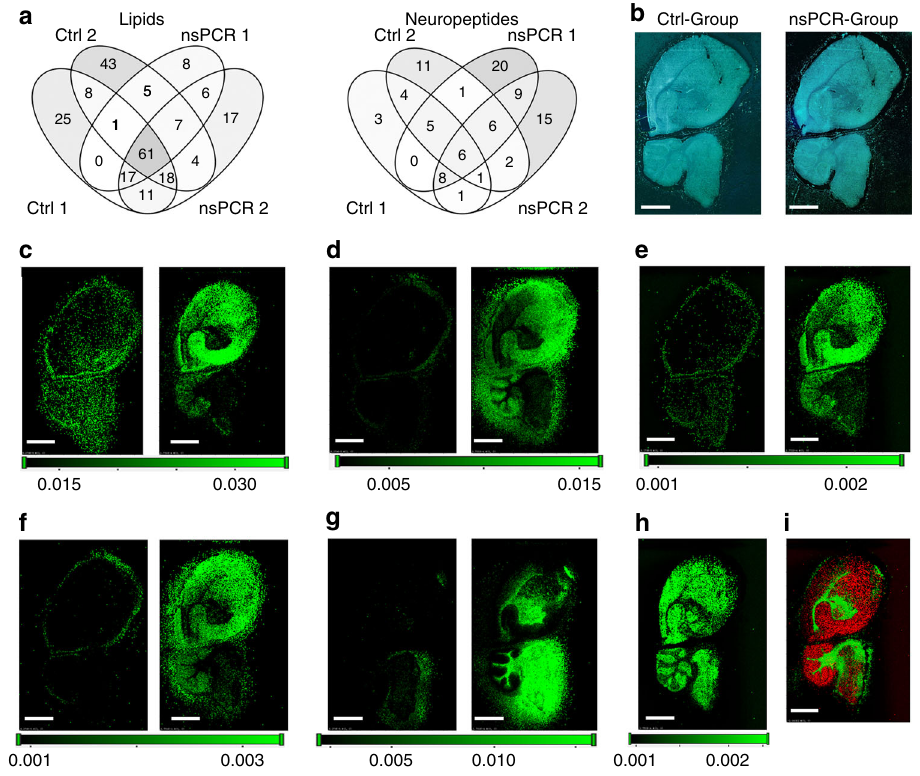
Fig. 2 Enhanced neuropeptide visualization via nsPCR. a Venn diagrams showing two sets of comparative data for both lipid and neuropeptide identi fi cations with and without NBA treatments. b Optical images of mouse brain for control and experimental group with NBA. c Direct comparison of putative neuropeptide ADKNFLRFamide ([M + H] + , m/z 1009.568) without (left panel) and with NBA treatment (right panel); d APQRNFLRFamide ([M + H] + , m/z 1147.650); e RKPPFNGSIFamide ([M + K] + , m/z 1199.610); f RSAEGLGRMGRL ([M + K] + , m/z 1340.660). g Direct comparison of lipid (triacylglycerol, [TAG(52:9) + Na] + , m/z 867.651) distributions in mouse brain between control and labeled group with NBA. h Typical distribution of lipid (monomethyl-phosphatidylethanolamine, [MMPE(44:10) + 34 + Li] + , m/z 878.645) with NBA. i Overlay of lipid (phosphatidylcholine, [PC(36:1) + H] + , m/z 788.615, red) and neuropeptide ([SKNYLRFamide + H] + , m/z 926.522, green) ion images. All images were obtained with m/z tolerance of 5 ppm. Scale bar, 2 mm. Step size, 50 μ